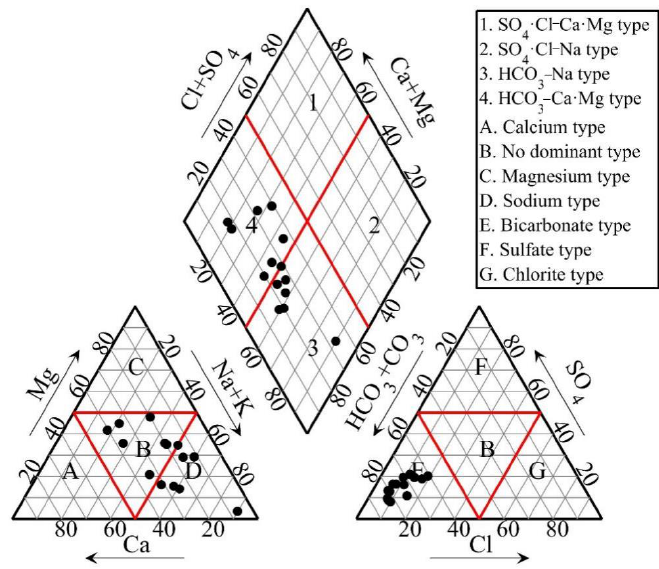
Figure 3. Piper diagram of phreatic groundwater in the study area.